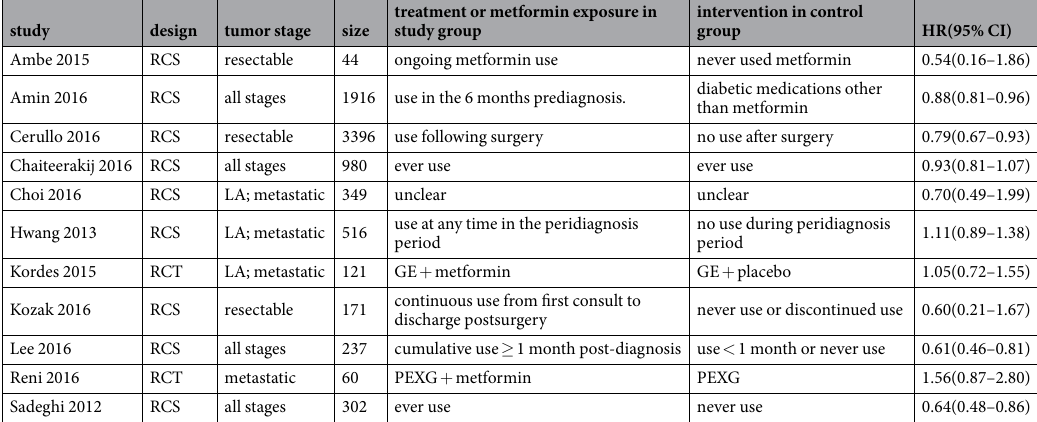
Table 1. Characteristics of included studies. Abbreviations: RCS = retrospective cohort study; PA = pancreatic adenocarcinoma; peridiagnosis period = between 6 months prediagnosis and one month postdiagnosis; GE = gemcitabine + erlotinib; PEXG = cisplatin + epirubicin + capecitabine + gemcitabine; all stages = resectable + locally advanced + metastatic; LA = locally